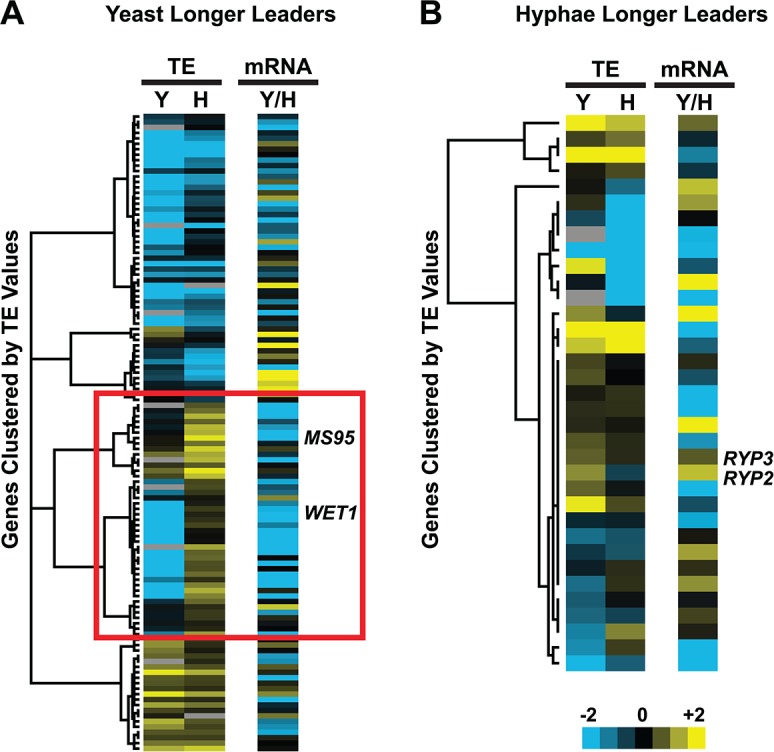
Many yeast-phase longer leader transcripts exhibit transcriptional and translational regulation.Yeast and hyphal phase TE values for G217B yeast-phase (A) and hyphal-phase (B) longer leader transcripts with TE values above the counting error threshold of 128 in at least one state (n = 116/120 transcripts for yeast n = 34/35 transcripts for hyphae). Transcript TE values were subjected to hierarchical clustering using an uncentered Pearson correlation. Data are displayed as a heatmap with yellow representing genes with higher TE values, blue representing genes with lower TE values, and grey representing genes that did not meet the counting error threshold. The corresponding Y/H mRNA expression values are shown alongside the clustered TE values with yellow representing transcripts upregulated in yeast cells and blue representing transcripts upregulated in hyphae. The yeast longer leader transcripts boxed in red indicated clusters where many transcripts are transcribed at a lower level and have a lower TE in yeast relative to hyphae. Particular genes called out in the text (MS95, WET1, RYP3, and RYP2) are labeled. Clustered heatmaps are given as S30–S33 Data.